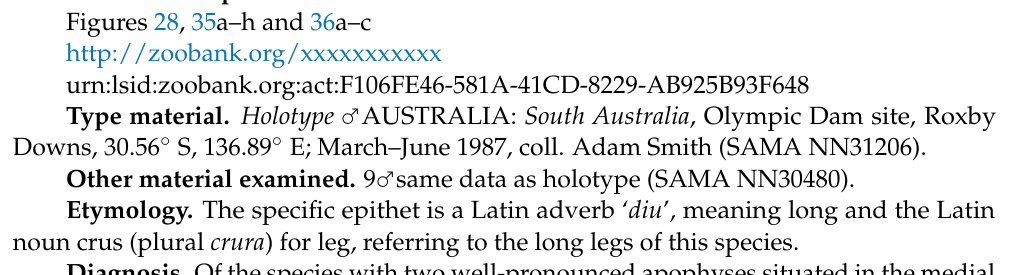
Figure 34. Ariadna deserta sp. nov. ♂ holotype (SAMA NN30493) from Witjira National Park (SA): ( a ) left pedipalp, prolateral view; ( b ) same, retrolateral view; ( c ) same, cymbium. Scale bar = 1 mm. Ariadna diucrura sp. nov.